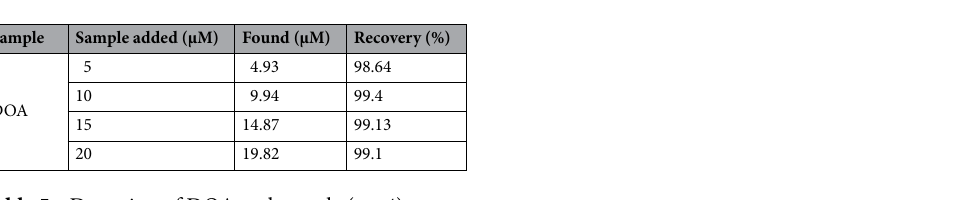
Table 5. Detection of DOA real sample (n = 4).